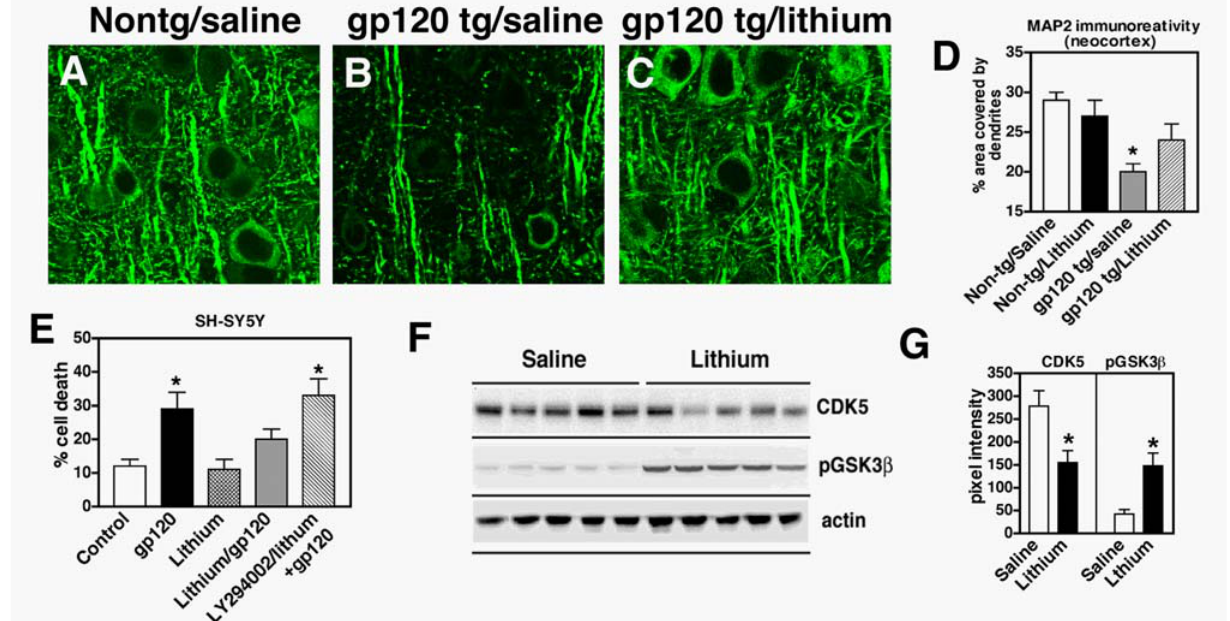
Figure 4. Neuroprotective effects of lithium in gp120 models via GSK3  and CDK5 phosphorylation. (a-d) Amelioration of the dendritic pathology (MAP2) in gp120 tg mice treated with lithium (daily injections for 2 weeks). (e) The neuroprotective effects of lithium against gp120 in SH-SY5Y cells are mediated by Akt. (f, g) Lithium downregulates CDK5 hyperactivation and inactivates GSK3  via